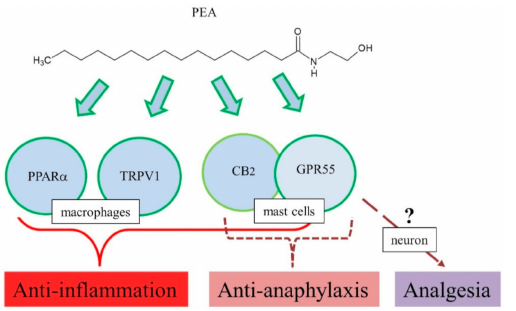
Figure 2. Proposed action mechanisms of PEA for anti-inflammation, anti-anaphylaxis, and